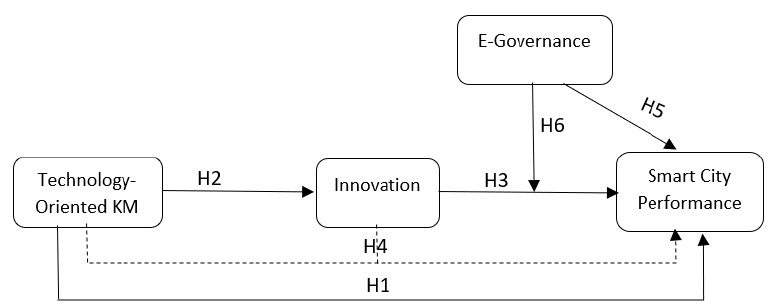
Figure 1. Research framework of AI-based KM on innovation and e-service delivery.